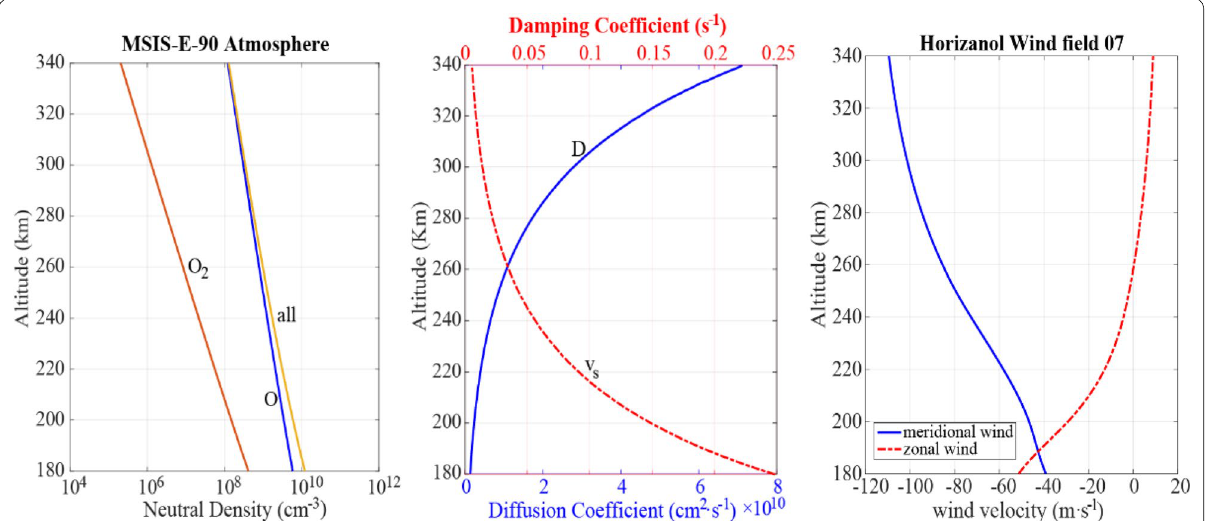
Fig. 2 The density of background neutral particles (left), the diffusion coefficient and damping coefficient of barium (middle), and the ambient wind